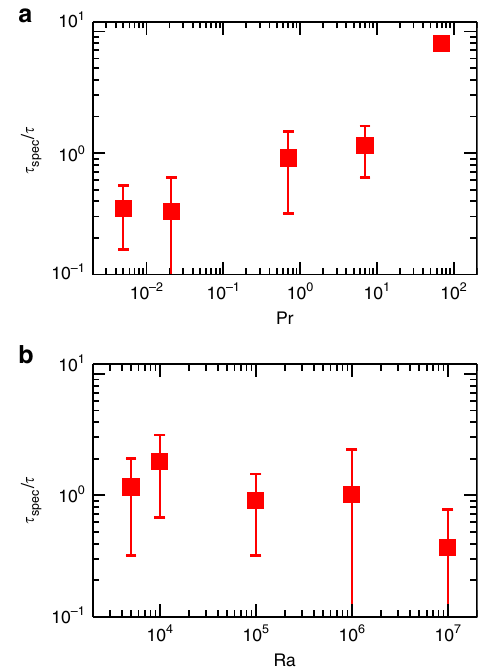
Fig. 6 Mean lifetime of turbulent superstructure τ spec in units of time scale τ . The lifetime is obtained from the duration of global maxima of the radially averaged temperature spectra. a Mean lifetime versus Prandtl number at Ra = 10 5 . b Mean lifetime versus Rayleigh number at Pr = 0.7. The error bars correspond to the standard deviation of the